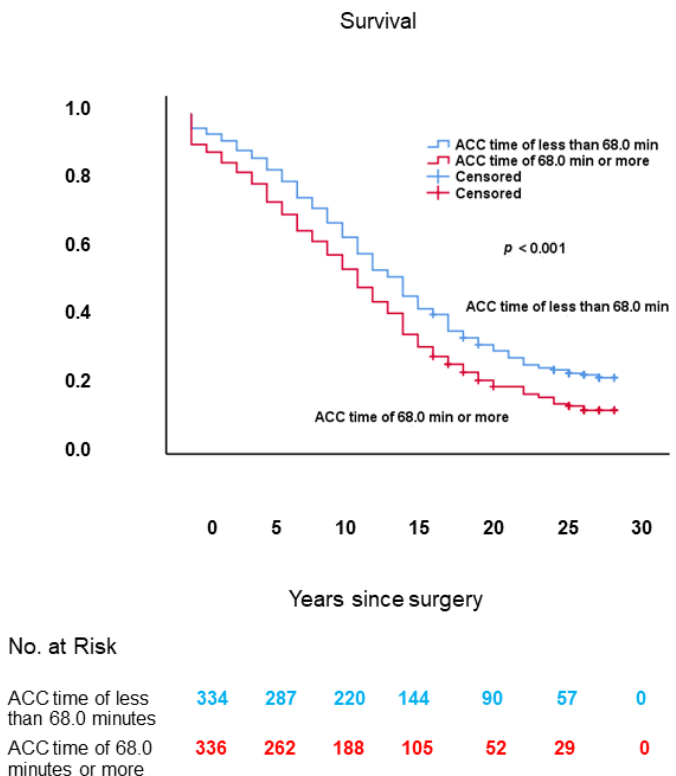
Figure 8. Kaplan–Meier survival curves, from date of surgery, of patients with ACC time of 68.0 min or more vs. those with ACC time of less than 68.0 min. ACC: aortic cross-clamp.